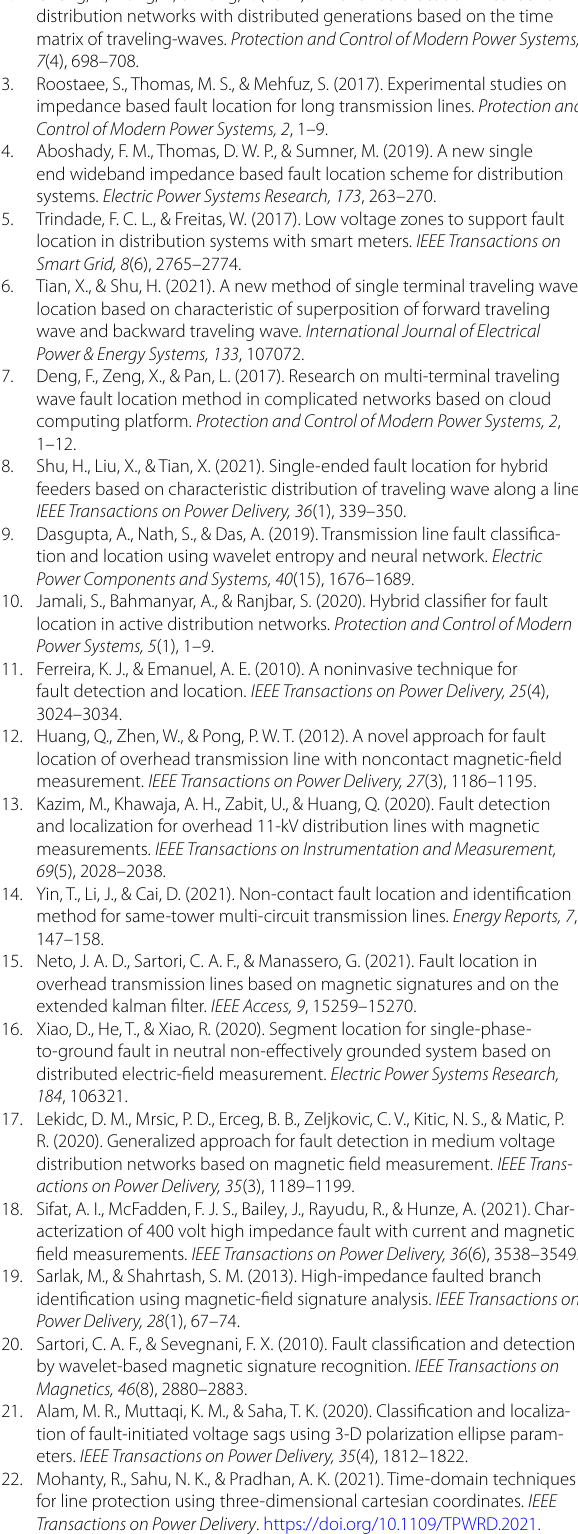
Table 9 Localization results of different methods Method Criteria R f